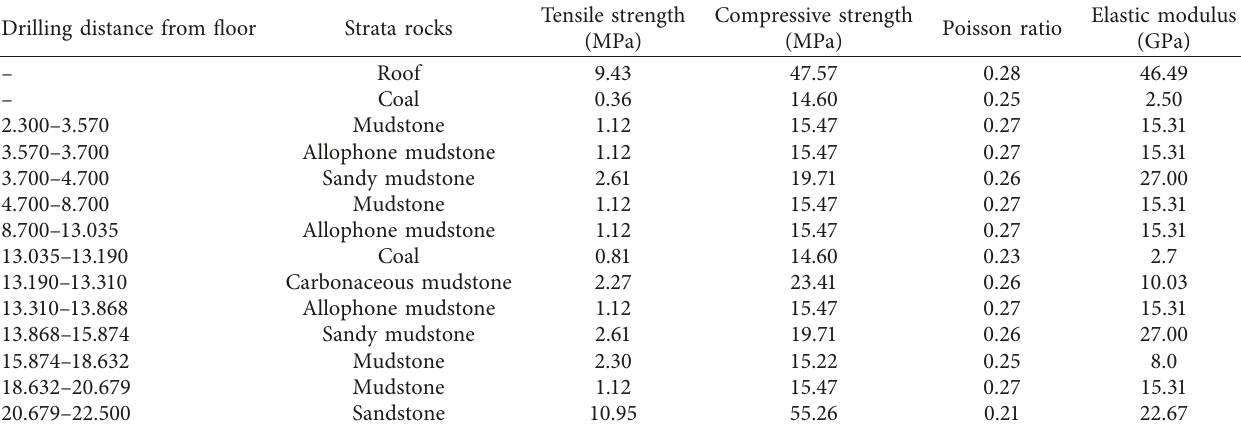
Figure 1: Layout of the No. 100502 mining faces. Table 1: Lithology and mechanical parameters of the floor strata rocks.